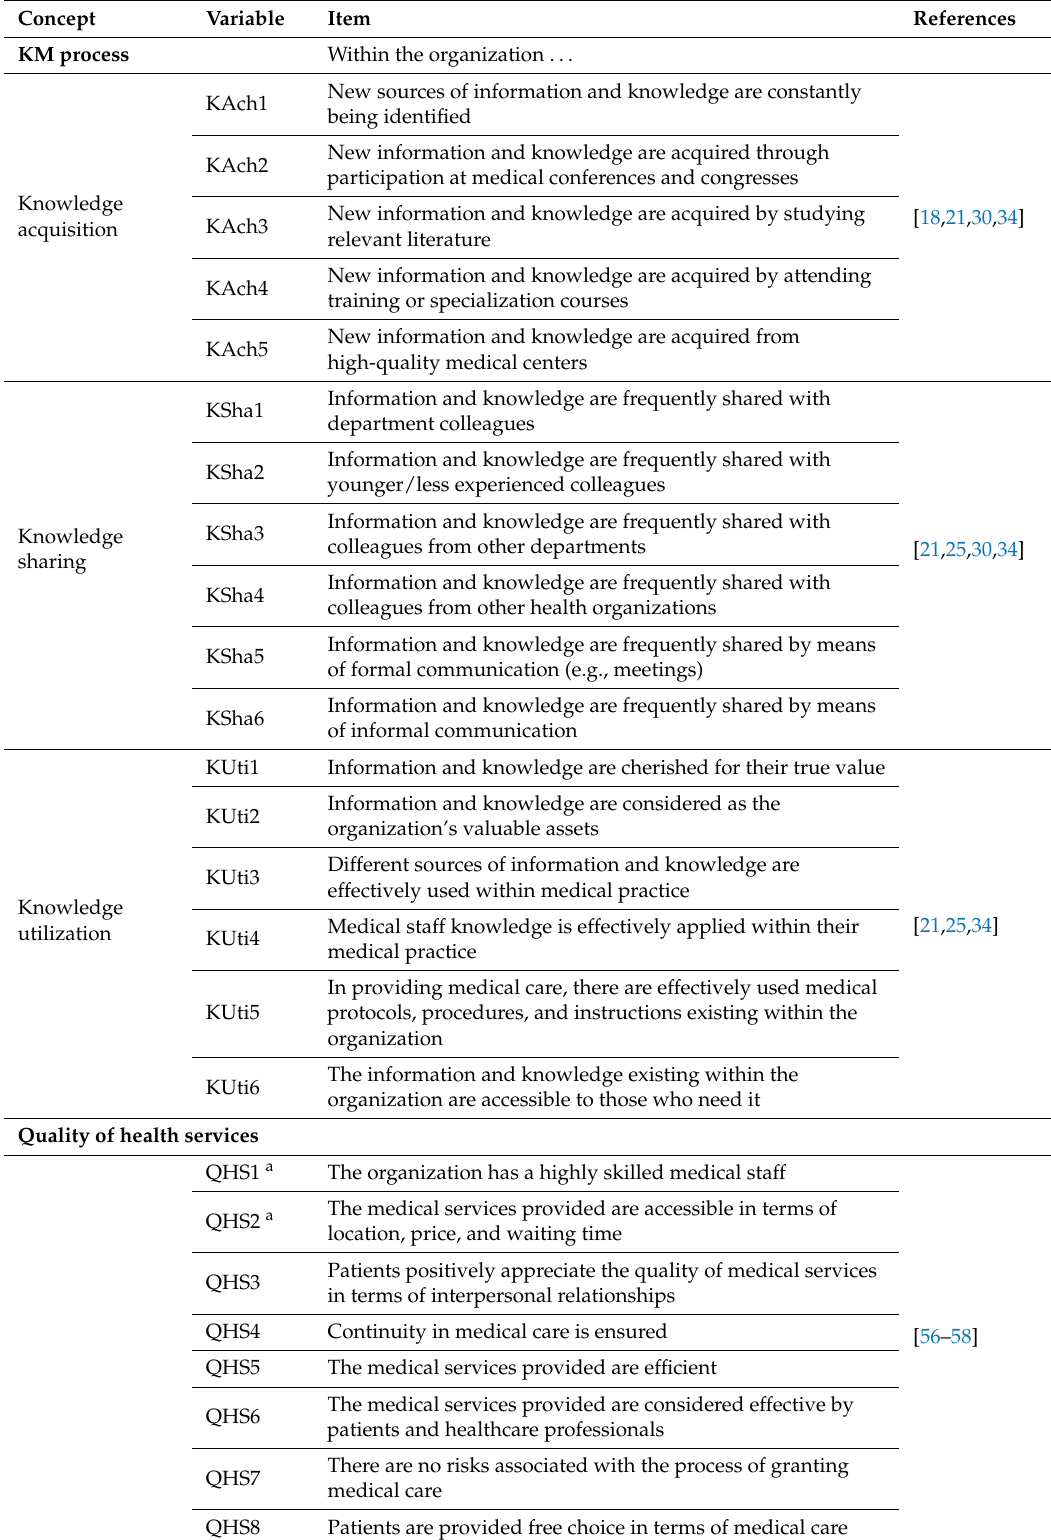
Table A1. Conceptual framework of